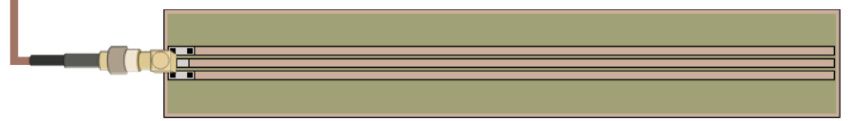
Figure 14. The schematization of the SE planar tri-filar to determine skin hydration [48]. The TDR responses were determined using a saline solution with different sugar concentrations (Figure 15).